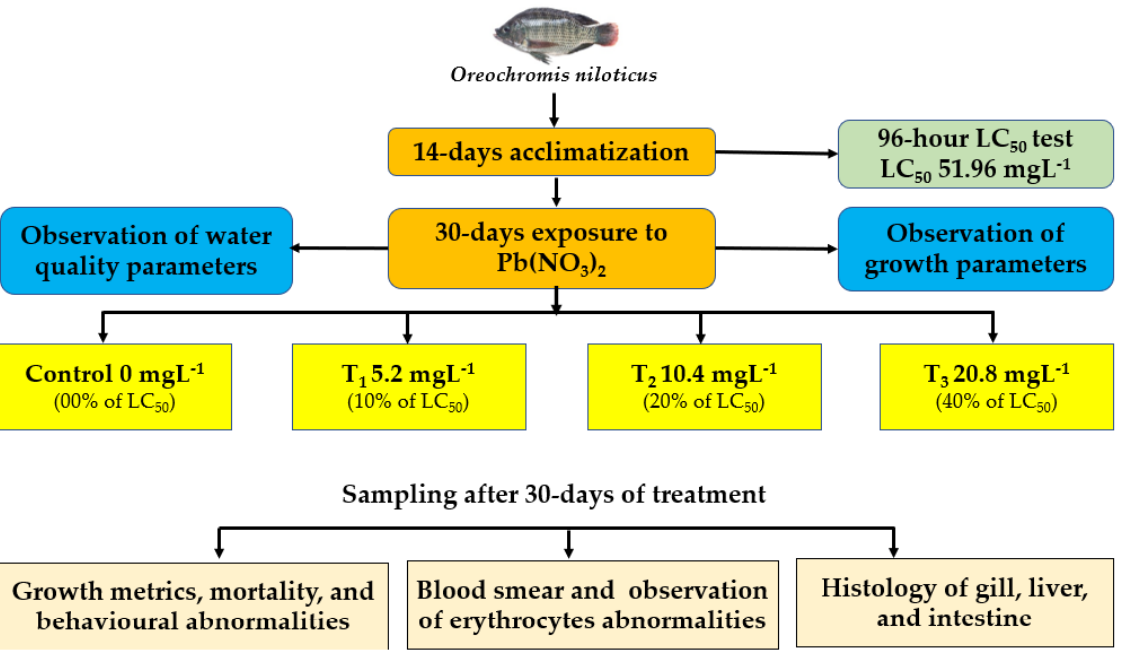
Figure 1. A flow chart illustrating the overall steps of the methodology. Table 1. Experimental design with different dosages of Pb(NO 3 ) 2 exposure.